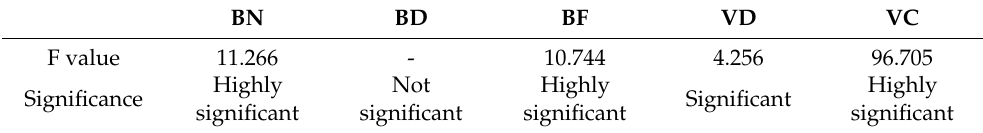
Table 8. ANOVA results of ∆